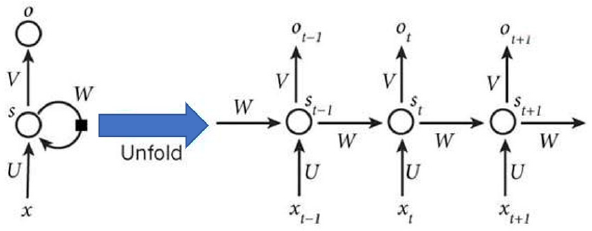
Figure 6. Diagram of the expansion of a recurrent neural network.